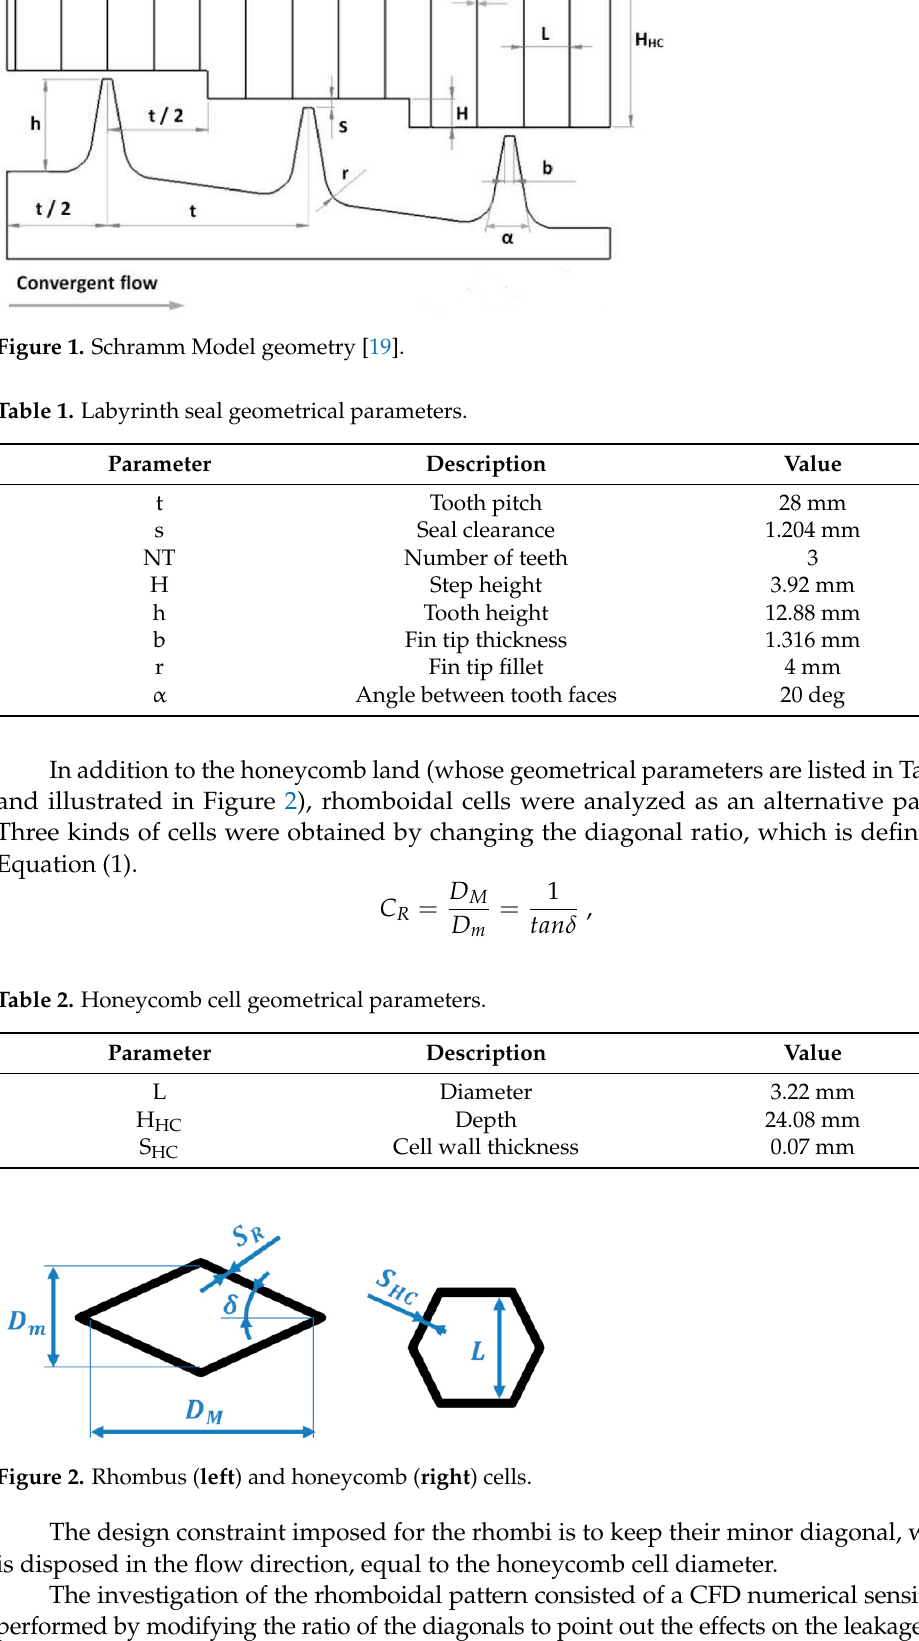
2.309 Figure 3. CFD geometry, boundary conditions [19].